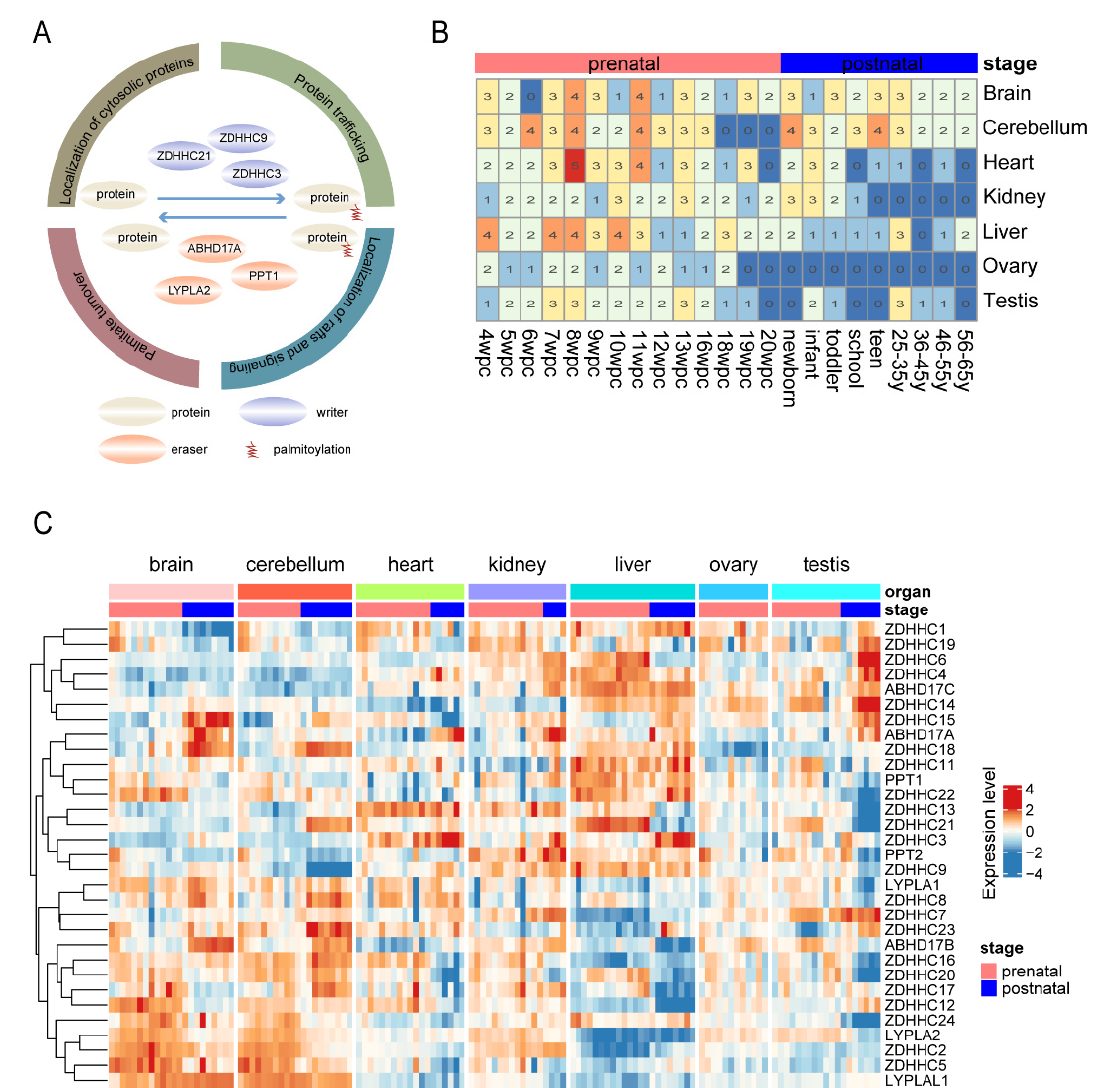
Figure 1. Dynamic expression of palmitoylation regulators during organ development. ( A ) Summary of regulation of palmitoylation modification. ( B ) Generalization of the number of samples at different developmental periods for seven organs. ( C ) Heatmap showing the expression levels of palmitoylation regulators in different organs. The prenatal and postnatal samples are shown in pink and blue colors.